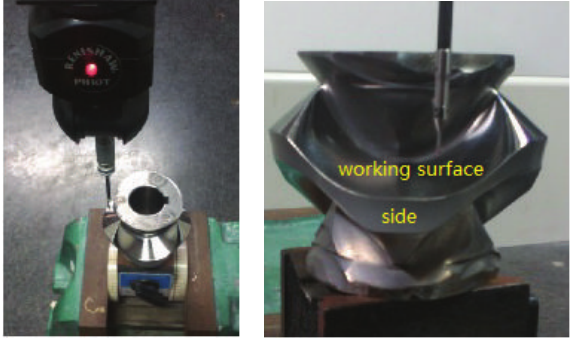
Figure 11: The arc surface cam.